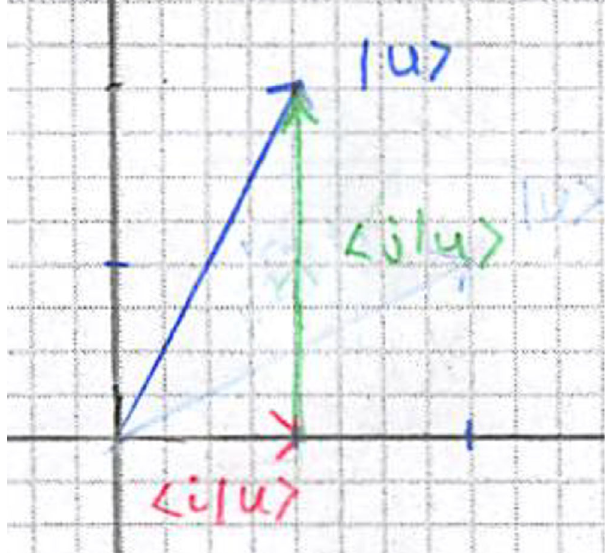
FIG. 1. Student work depicting j u i as a vector on a Cartesian coordinate plane. Here the individual components are labeled with inner products in Dirac